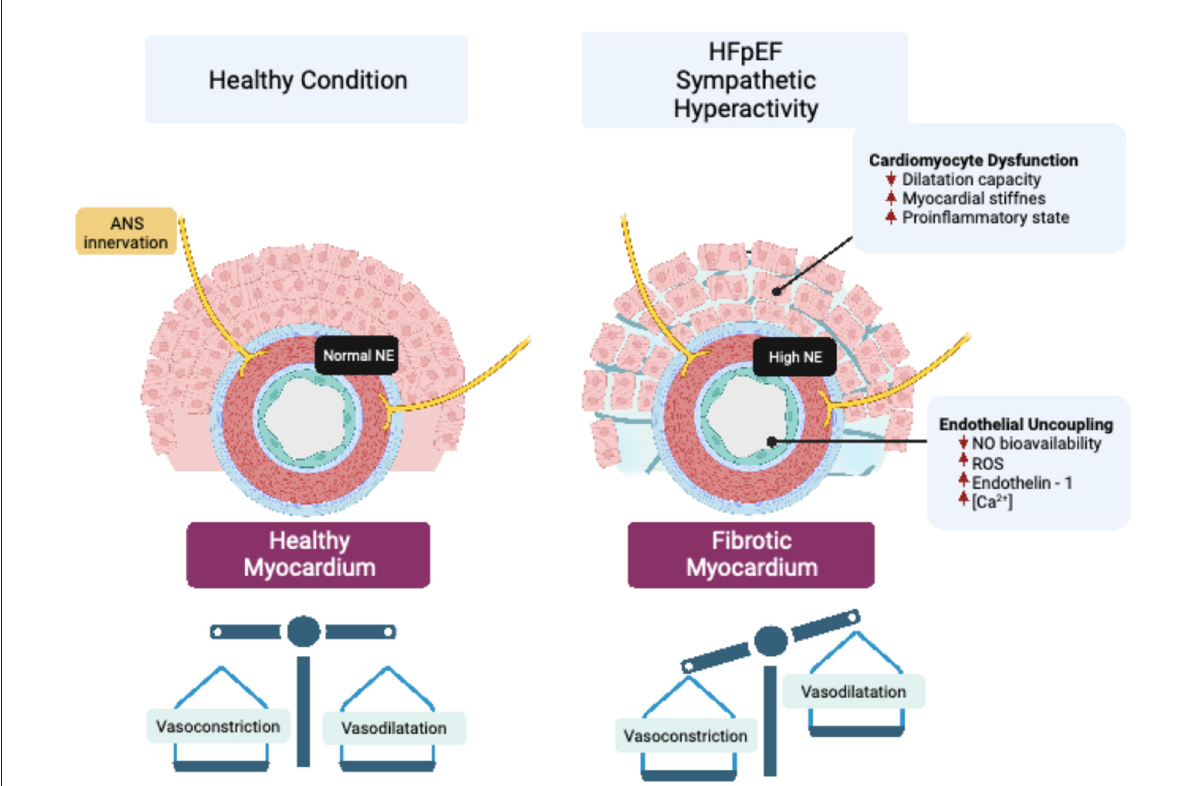
FIGURE1 Vascular sympathetic neurotransmission and endothelial dysfunction in HFpEF. Enhanced sympathetic outflow led to increased release of norepinephrine (NE), which impair cardiovascular endothelial function by modifying peptides and signaling molecules that regulate perfusion to vascular beds. Endothelial uncoupling, in turn, can generate cardiomyocyte dysfunction that affects the structure and function of the heart through mechanisms associated with impaired myocardial dilatation capacity, stiffness, and